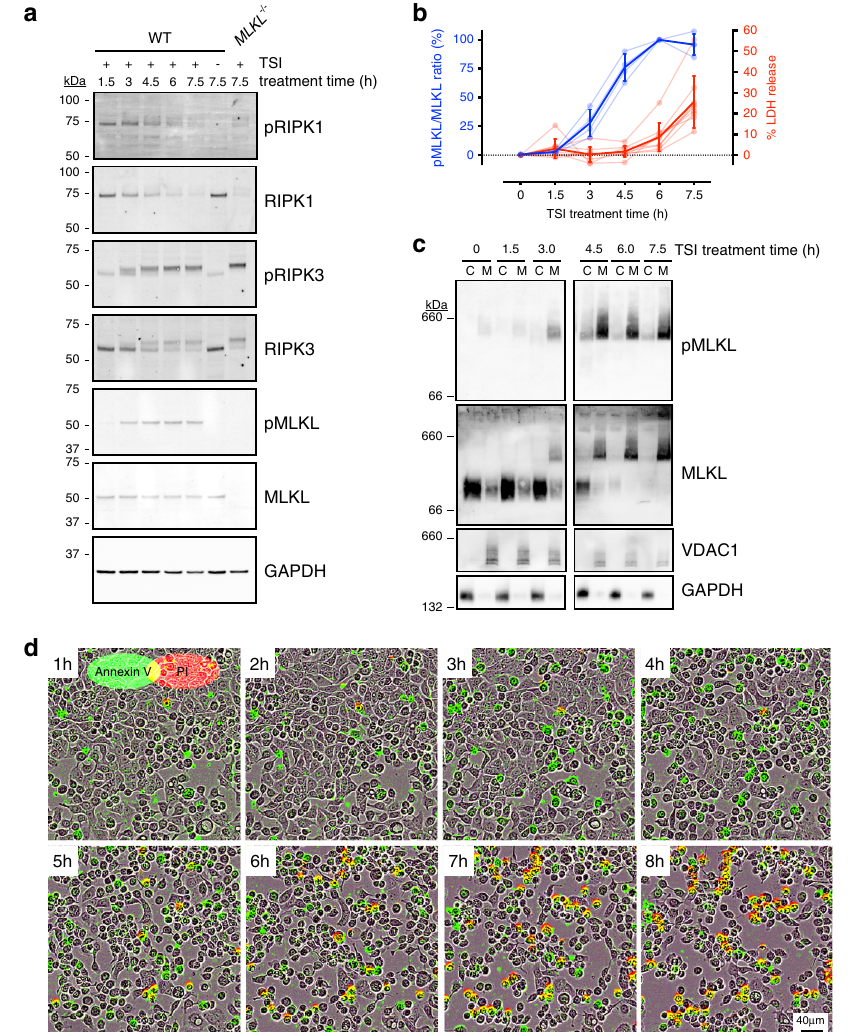
Fig. 1 A temporal gap occurs between MLKL activation and necroptosis. Wild-type (WT) and MLKL − / − HT29 cells were treated with media alone or the necroptotic stimuli, TNF and Smac-mimetic and pan-caspase inhibitor, IDN-6556, (TSI) for the indicated time period and chronological RIPK1, RIPK3, and MLKL phosphorylation ( a ), plasma membrane lysis ( b ), MLKL oligomerization and membrane-association ( c ), and plasma membrane damage with cell death ( d ) were measured. a Whole-cell lysates were fractioned by SDS-PAGE and immunoblotted to determine the extent of RIPK1, RIPK3 and MLKL phosphorylation over time. The displayed immunoblots are representative of n = 2 independent experiments for RIPK1/3 and n = 4 independent experiments for MLKL. b Left-hand y-axis plots the ratio of the pMLKL and MLKL immunoblot signals (relative to the t = 6 h time point value) across n = 4 independent experiments. Mean± SD. Right-hand y -axis plots the extracellular release of lactate dehydrogenase (LDH) as an index of plasma membrane lysis (relative to detergent-treated cells) across n = 9 independent experiments. Mean± SEM. All data are included in the Source Data fi le. c Subcellular fractions of the cytosol (C) and membrane (M) were subjected to Blue Native-PAGE and immunoblotted to assess MLKL phosphorylation, oligomerization and membrane-association. Fractionation was veri fi ed by probing for the membrane protein, voltage-dependent anion channel 1 (VDAC1), and the cytosolic protein, glyceraldehyde-3-phosphosphate dehydrogenase (GAPDH). Data are representative of n = 2 independent experiments. d Sequential time-lapse micrographs of Annexin V binding (Annexin V; green) and propidium iodide-uptake (PI; red) as indices of plasma membrane damage and cell death, respectively. Micrographs are representative of n = 4 independent